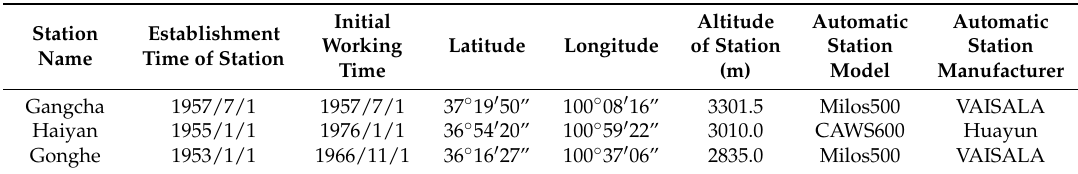
Table 2. National meteorological stations in the Qinghai Lake basin.